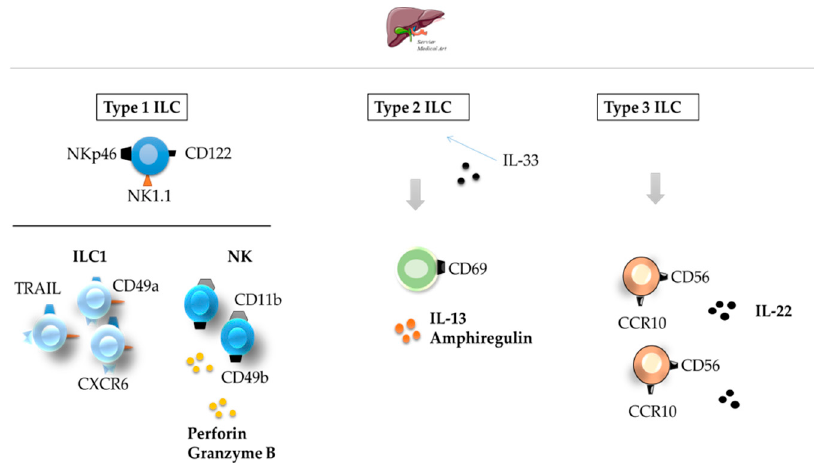
Figure 3. ILCs in the healthy liver. All three types of ILCs can be found in the healthy liver. Type 1 ILCs are the most abundant ILC type found in the healthy liver. Type 2 and 3 ILCs represent only about 5% of all ILCs. ILC—innate lymphoid cell; CCR—C-C motif chemokine receptor